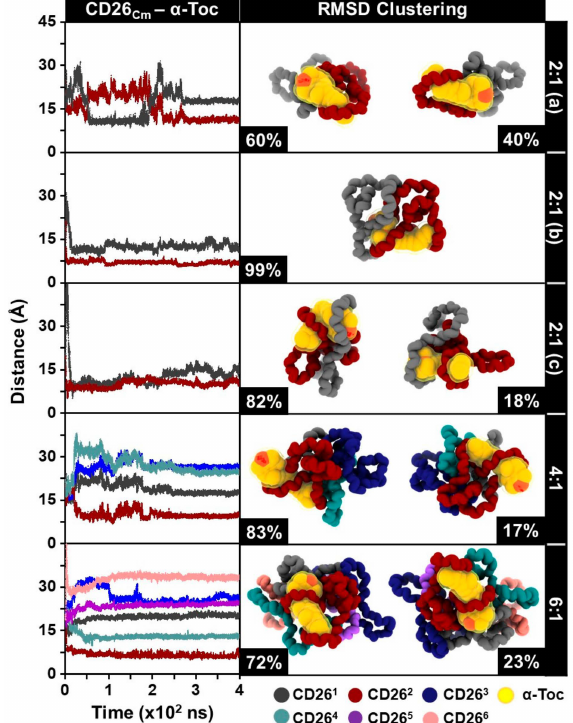
Figure 3. ( Left ) The distances between the C m of CD26 and α -tocopherol and ( right ) RMSD clustering of the 2:1 ( a ), 2:1 ( b ), 2:1 ( c ), 4:1, and 6:1 complexes. The difference between models 2:1 ( a – c ) is CD26 beginning position